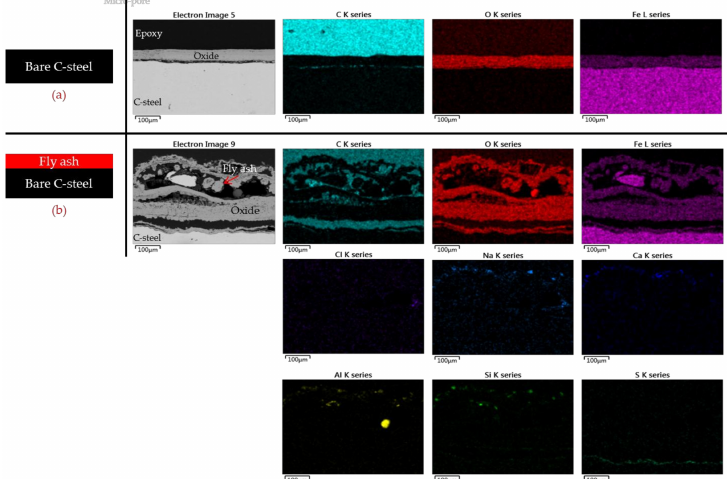
Figure 7. EDS maps for the cross-sectional surface of ( a ) the non-coated steel without fly ash deposition and ( b ) with fly ash deposition at 800 ◦ C.